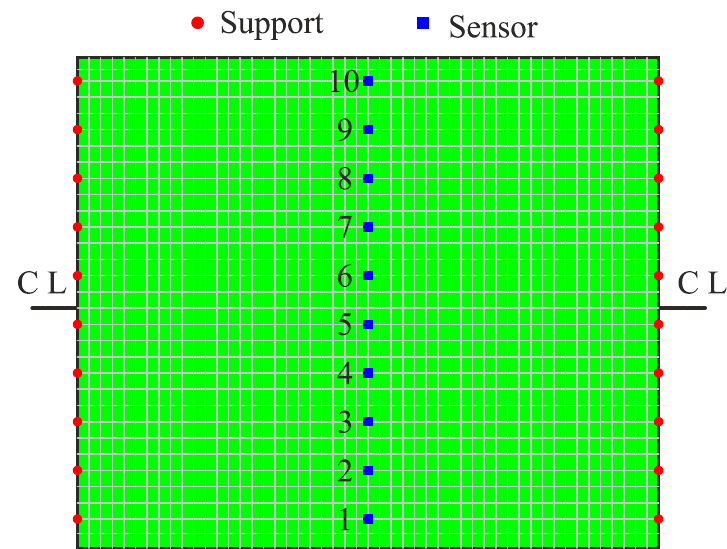
Fig. 7 Finite element view of the bridge deck and the position of the sensors and supports